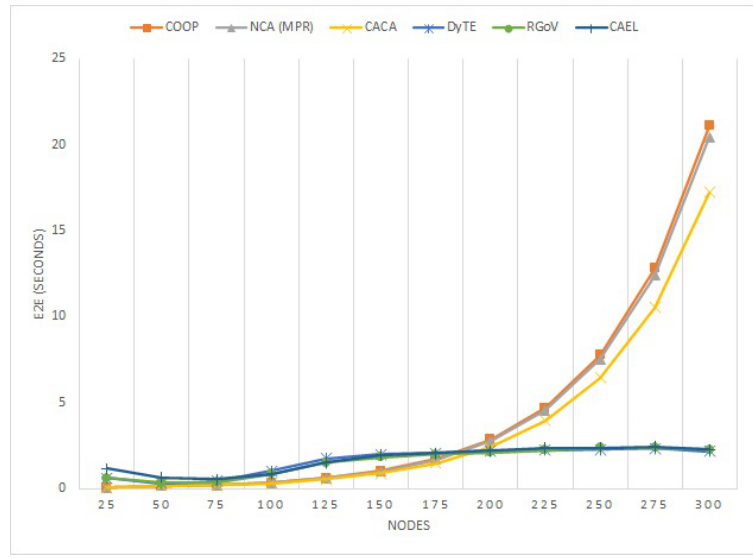
Figure 10. End-to-end delay against various number of